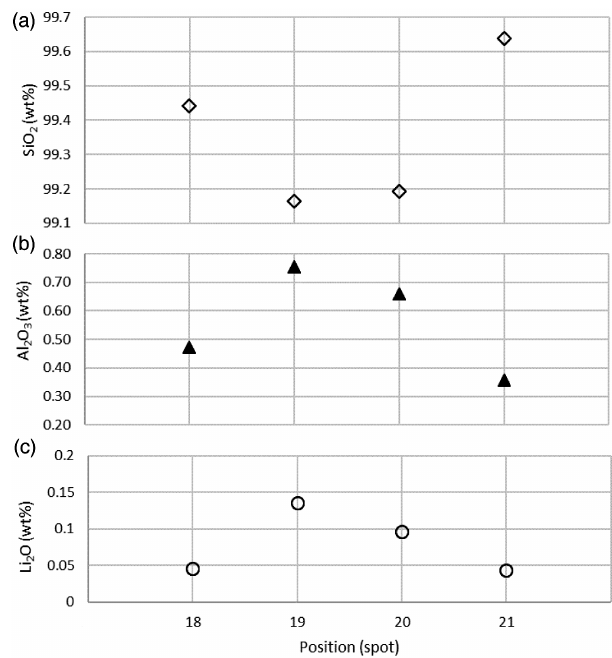
Figure 9. Three concentration plots illustrating the distribution of Si (a) , Al (b) and Li (c) across the area shown in Fig. 8. Both Al and Li show a positive correlation and do correlate negatively with Si. Obviously the clear quartz core (spots 19 and 20) contains more Al / Li than quartz with feathery textures (spots 18 and 21), while Si at the same time shows lower